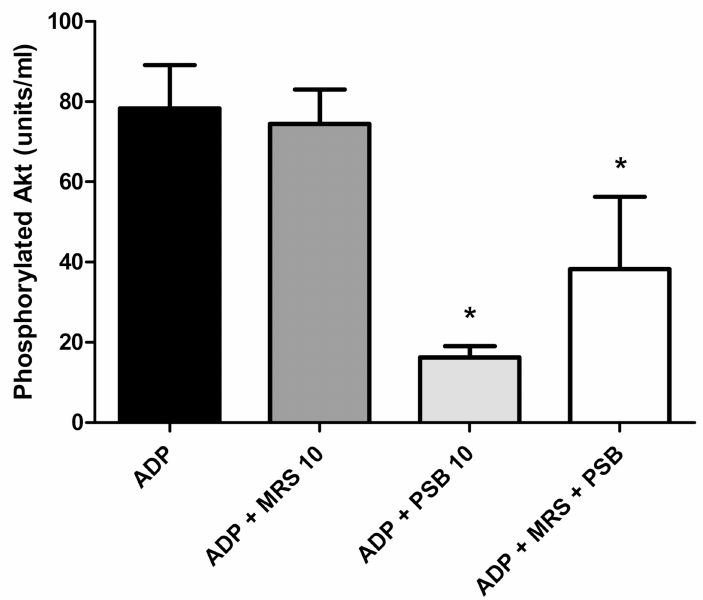
Figure 5. E ff ects of MRS2500 (MRS) and PSB0739 (PSB) both at 10 µ mol · L − 1 , individually and in combination on PI3K-mediated phosphorylation of Akt1 measured in the lysates of ADP (100 µ mol · L − 1 )-activatedplateletsusinganELISAprocedure. Theresultsof5experiments( n = 3 donors) are presented as the mean values ± SDs as units phosphorylated Akt1 · mL − 1 . * p < 0.008 for comparison of PSB0739 alone and in combination with MRS 2500 with the control